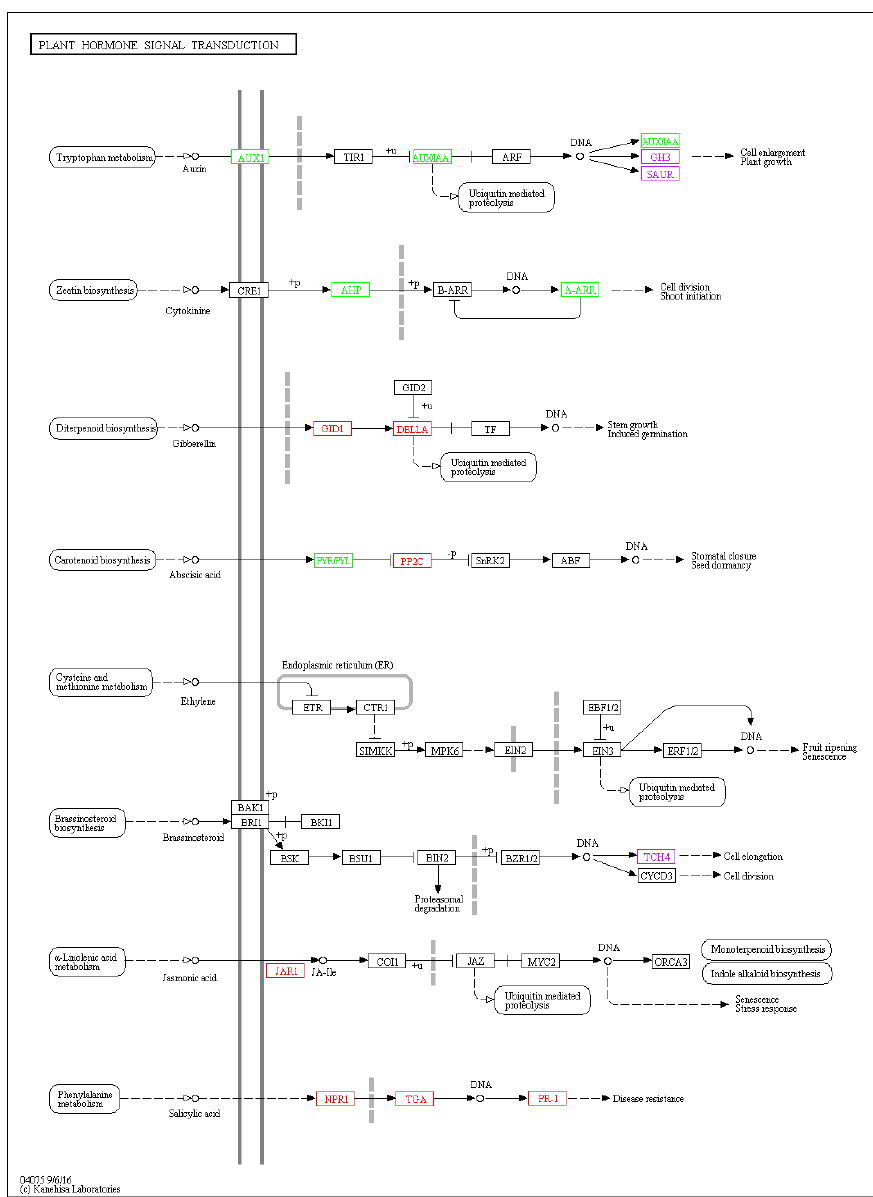
Figure 5. Visualization of plant hormone signal transduction (ko04075) KEGG pathway for two tea cultivars. The DEGs comparisons of anthracnose infected leaves versus healthy leaves was depicted by boxes in di ff erent colors, with red colour representing upregulation, green colour representing downregulation and purple colour representing mixture of upregulation and downregulation. Other boxes mean no DEGs mapping to KEGG ontology terms.